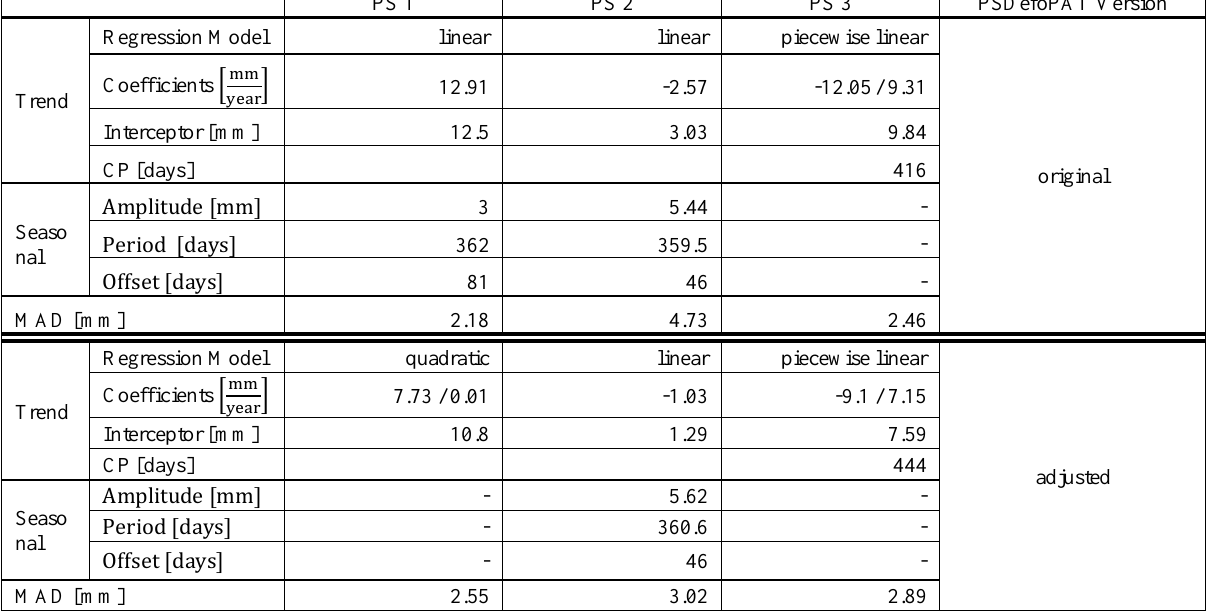
Table 1 . Parameters of the estimated trend and seasonal